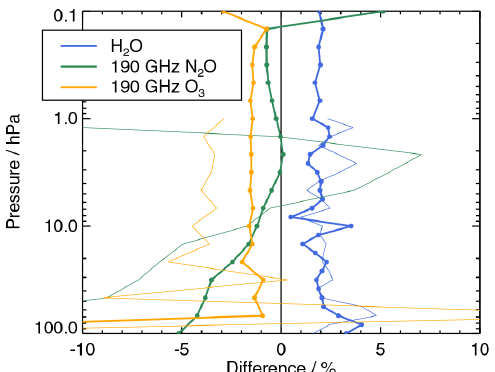
Figure 13. Thick lines with circles show the predicted impact of a 1.3% change in the 190GHz sideband fraction on the MLS H 2 O (blue), 190GHz N 2 O (green), and 190GHz O 3 (orange) products based on simulated retrievals of a model atmosphere. Thin lines show the corresponding 2010–2019 drift rates. For H 2 O and N 2 O, these are taken from 50 ◦ S–50 ◦ N ACE-FTS comparisons, whereas they are taken from comparisons with the MLS 240GHz “standard product” ozone for O 3 (Fig.